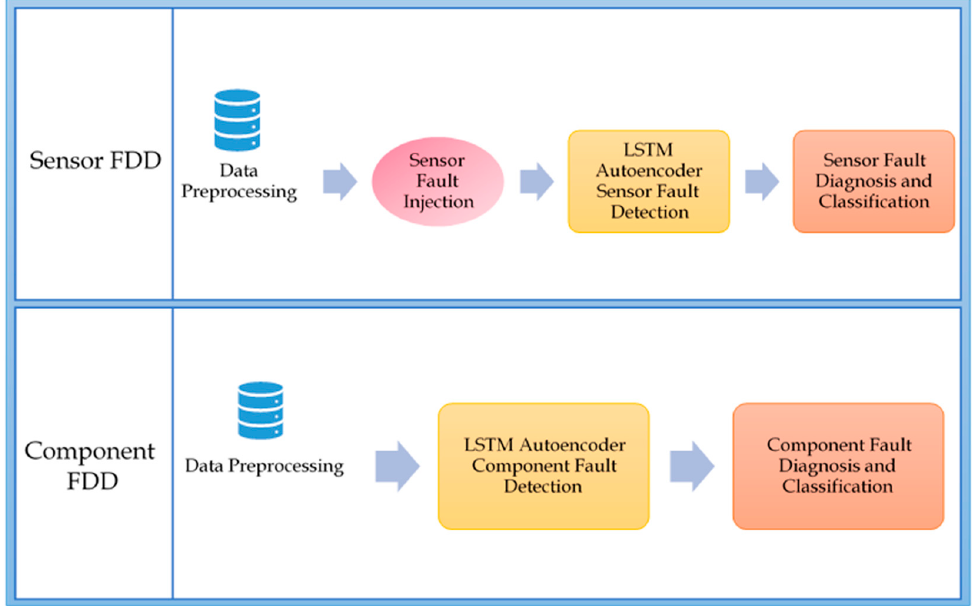
Figure 1. An Overview of the Two Experiments to Achieve FDD in Hydraulic Test Rigs for both Sensor and Component Faults.